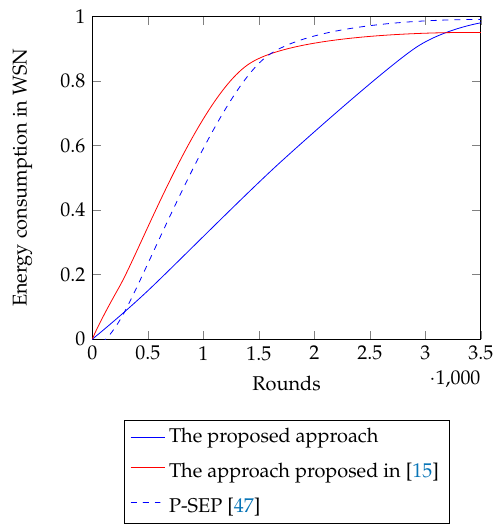
Figure 8. Average energy consumption of the WSN in each round.